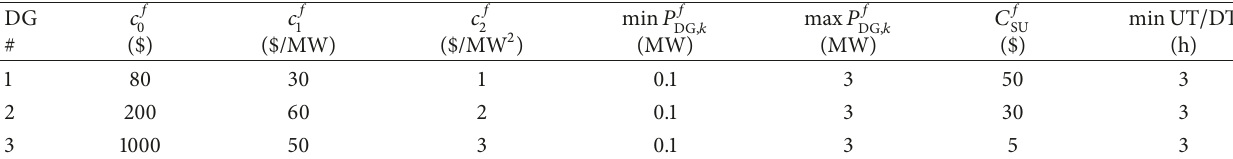
Table 1: Technical parameters of the DGs in the